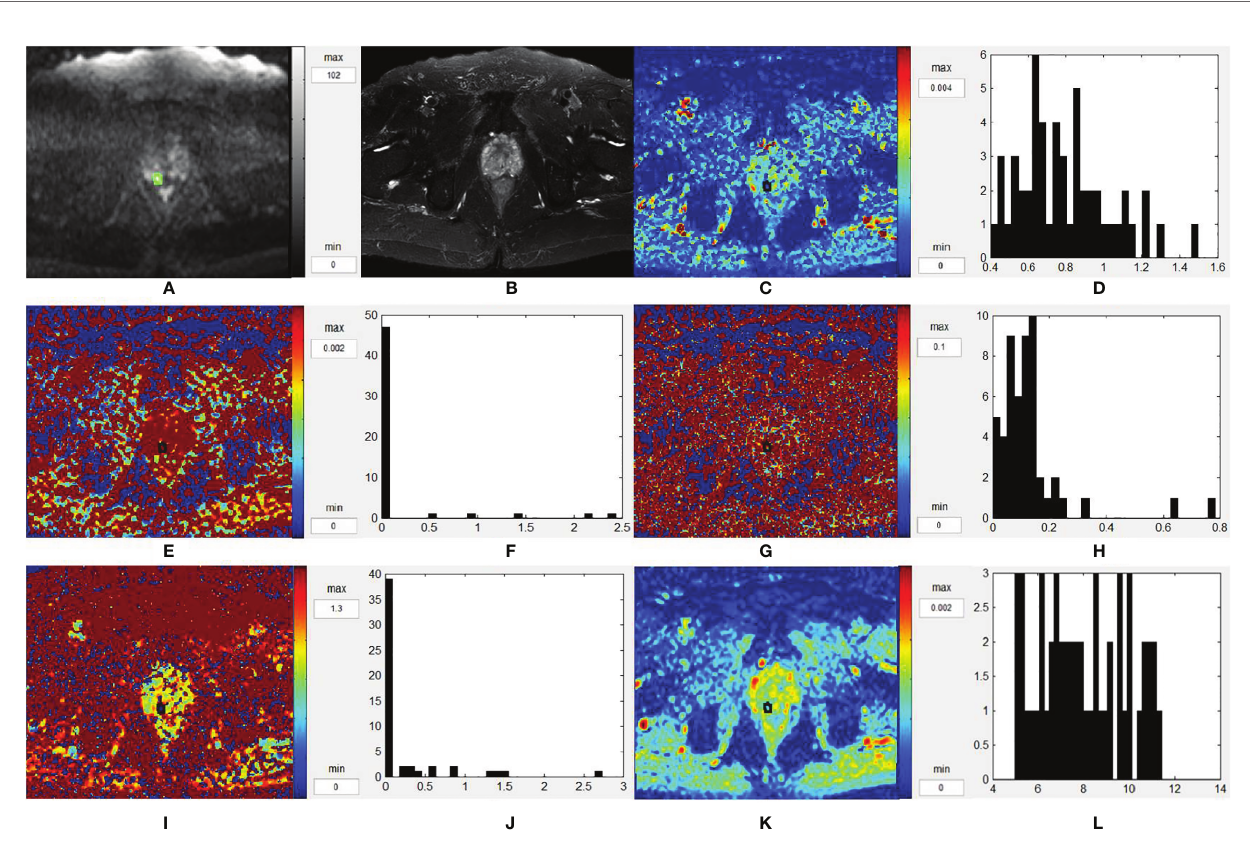
FIGURE 5 | Representative images from a 63-year-old BPH/prostatitis patient, as outlined on the images. (A – L) Axial DWI ( b = 1,500 s/mm 2 ), axial T2WI, D map, histogram of D , D * map, histogram of D *, f map, histogram of f , K map, histogram of K , ADC map, and histogram of ADC, respectively. BPH, benign prostatic hyperplasia; T2WI, T2-weighted images; DWI, diffusion-weighted images; ADC, apparent diffusion coef fi